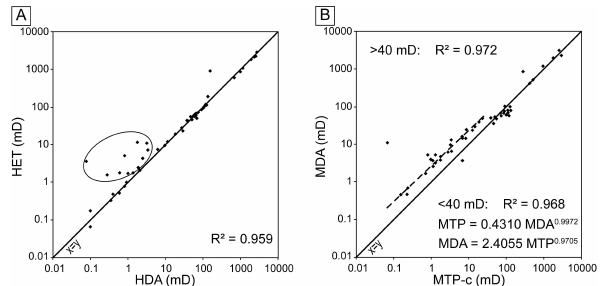
Fig. 5. Comparison of different gas permeameters: (A) the Has- sler cell devices ErgoTech gas permeameter (HET) versus the gas permeameter in Darmstadt (HDA), and (B) the minipermeameters Miniperm Darmstadt (MDA) versus TinyPerm II (MTP). The MTP values are corrected by − 37% (MTP-c) to compensate for reduced flow trajectories. The bisectrix ( x = y ) indicates positive or negative aberrations of the measuring results, and the dashed line indicates the regression line of the resulting transform equations for standard- ization. Note the bi-logarithmic scales.